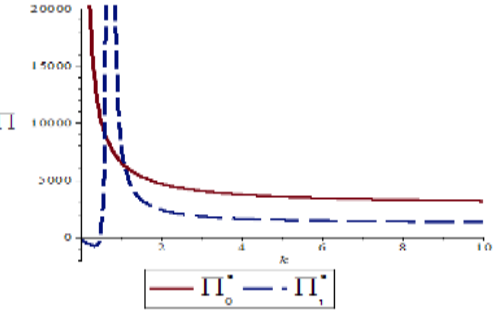
Figure 12. E ff ect of green cost parameter k on the revenue of supply chain networks under di ff erent